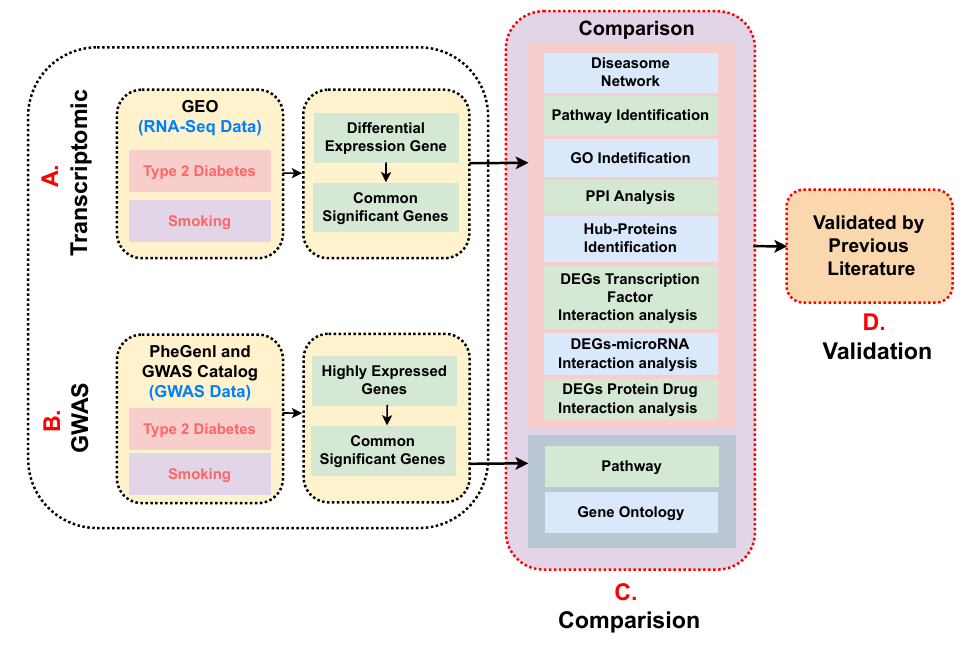
Figure 1. The figure demonstrate the working flow of our proposed methodology. A . Collected Transcriptomic datasets from GEO for Type 2 diabetes and Smoking. Generate DEGs and find out shared significant genes between both conditions B . Collected GWAS datasets from PheGenl and GWAS Catalog databases for Type 2 diabetes and Smoking. Generate DEGs and find out common significant genes between the conditions. C . Statistical analyses on Transcriptomic data to identify Pathway, Gene Ontology, Diseasome Network, PPI Analysis, Hub-Proteins, DEGs Transcription Factor Interaction, DEFs–microRNA Interaction, and Protein–Drug Interaction. Comparison between Transcriptomic and GWAS analysis based on Pathway and Gene Ontology. D . Validated the results by previous literature to find the biological